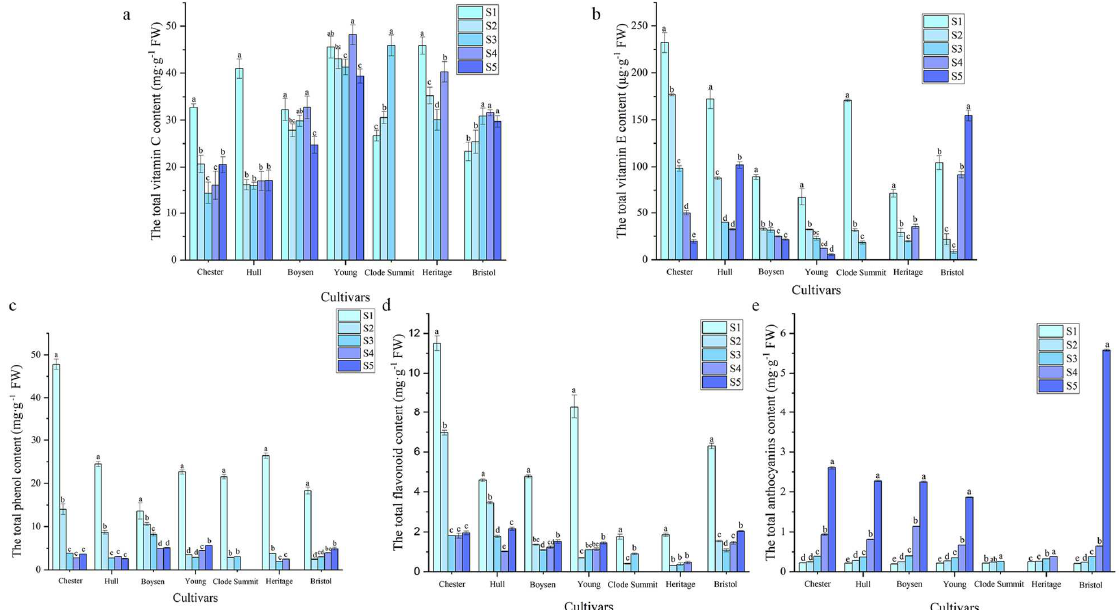
Figure 3. Variation in active antioxidant substance content in fruits of different Rubus cultivars at different developmental stages. ( a ) Vitamin C; ( b ) vitamin E; ( c ) total phenols; ( d ) total flavonoids; and ( e ) anthocyanins. Different letters indicate significant differences between the populations ( p < 0.05). Different colors represent different harvest periods.